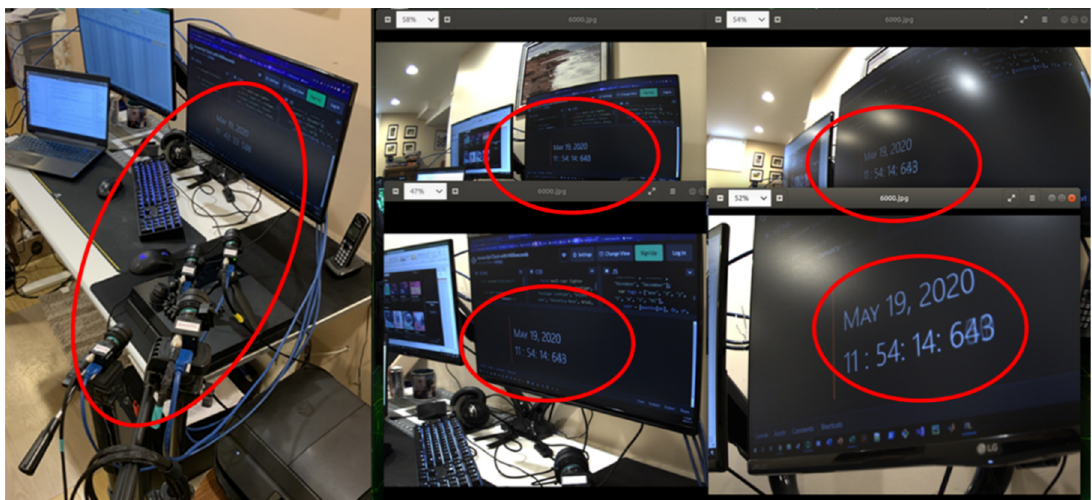
Figure A7 . Synchronization test layout and validation images for a four-camera setup capturing at 60 fps. All cameras show the same frame of the millisecond clock after 10,000 images .